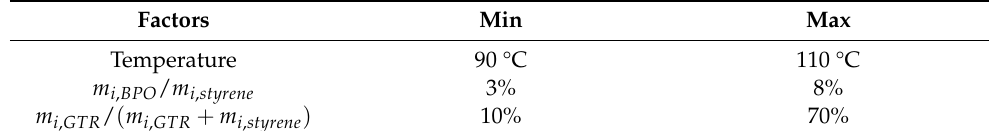
Table 1. Range of operating conditions.